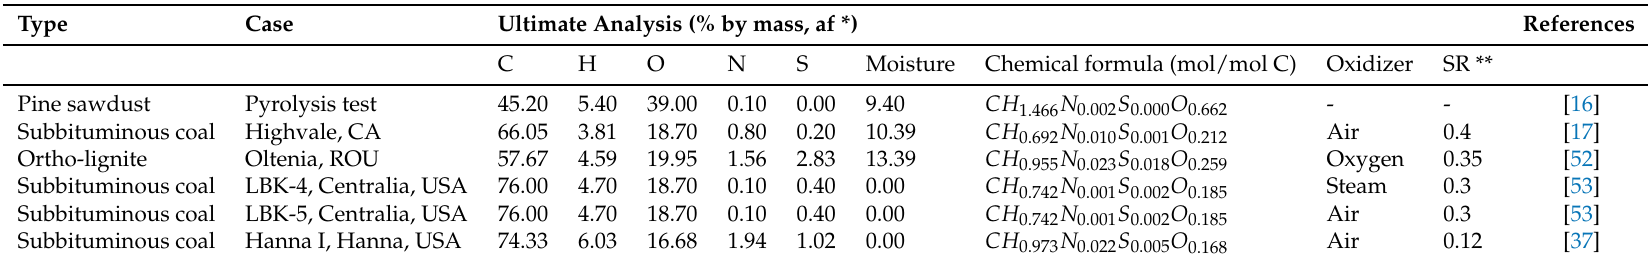
Table 3. Characterization of fuels considered for model